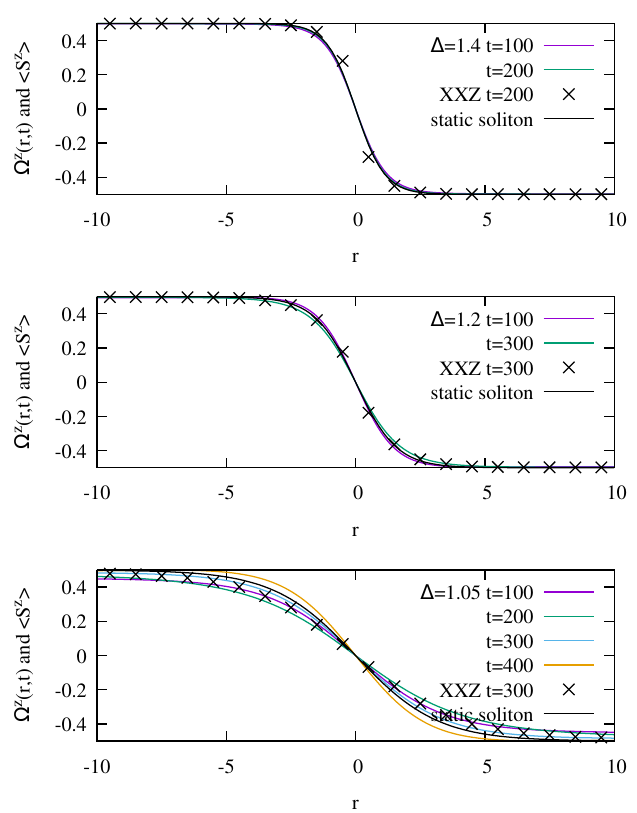
Figure 7: Ω z ( r , t ) and 〈 S z ( r , t ) 〉 as a function of the position r for ∆ = 1.4 (top), ∆ = 1.2 (middle) and ∆ = 1.05 (bottom) and for different times from t = 100 to t = 400. The LL solution shows some long-lived oscillations around some mean pro- file. These are visible (larger amplitude) for ∆ = 1.05. The full black line represents the static soliton of Eqs. (32). Black crosses: expectation value 〈 ˆ S z 〉 in the quantum XXZ chain (tDMRG simulations). To visualize the amplitude and the period of these oscillations, see Fig.